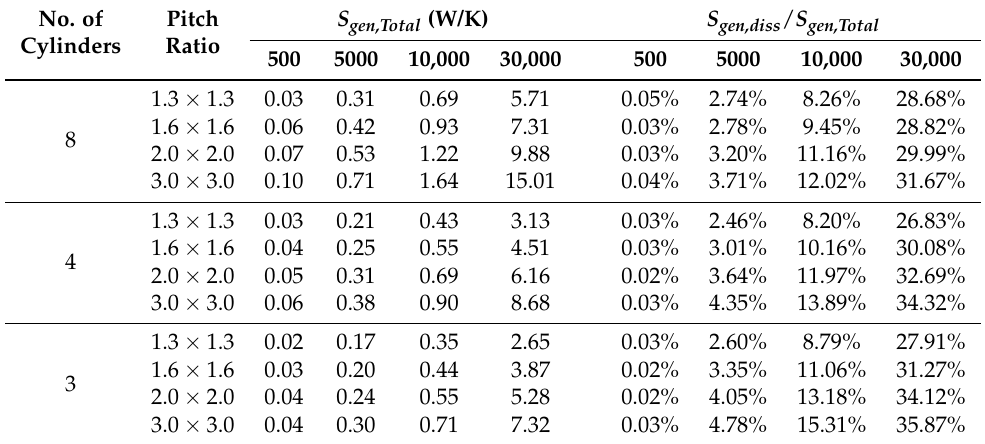
Table 4. Total entropy generation and ratio of entropy generation due to viscous dissipation to the total. S gen,Total (W/K) S gen,diss / S gen,Total No. of Pitch Cylinders Ratio 500